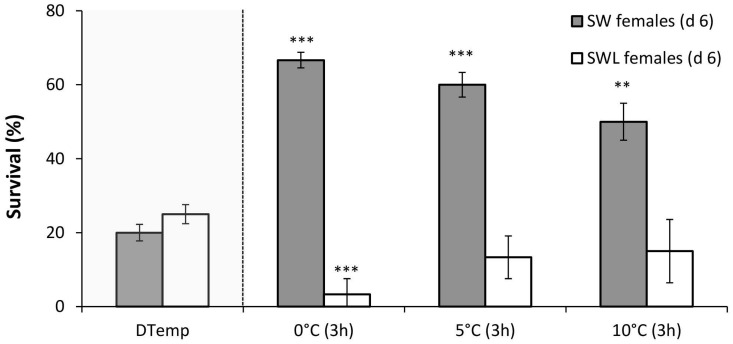
Mean survival (±S. E. M.), as a measure of Rapid Cold Hardening (RCH) ability, of d 6 Calliphora vicina females either developed on sugar, water and liver (SWL) or sugar and water (SW) only.RCH was induced using three different constant temperature pre-treatments (3 h at either 0, 5 or 10°C). Survival following RCH was compared with that following direct transfer to respective discriminating temperature (DTemp—in shaded grey area for comparison). * denotes significant differences at p<0.05, ** at p<0.01 and *** at p<0.001 (Bonferroni post-hoc), 6 replicates of n = 10 for each data point.